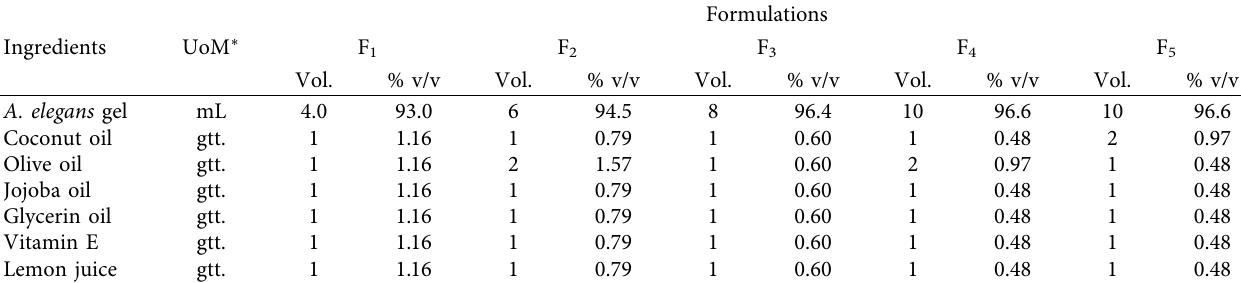
Table 2: Preparation of hair washing formulations from A. elegans